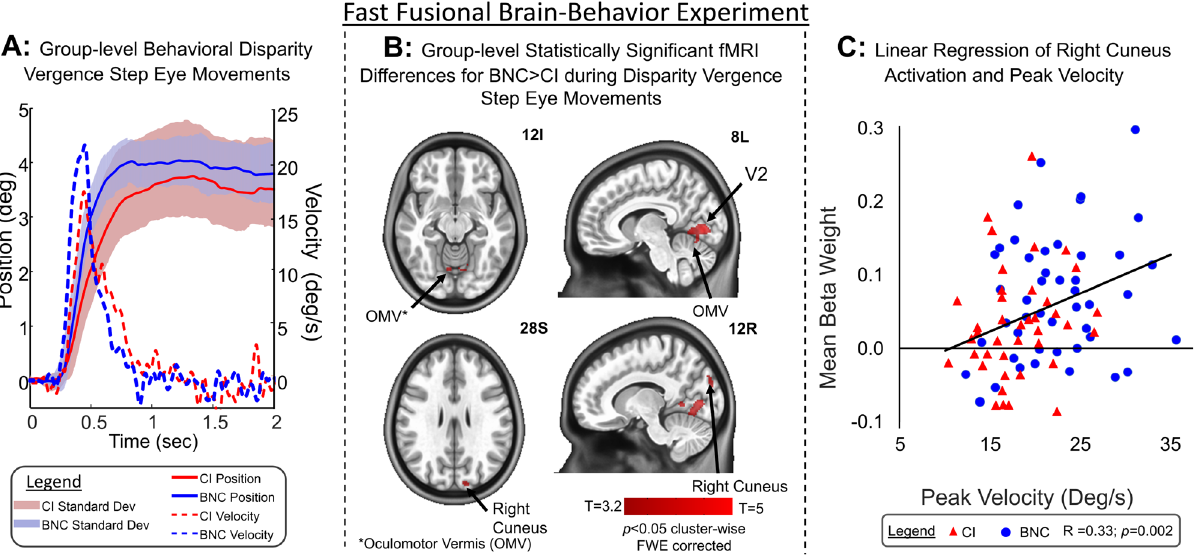
Figure 1. ( A ) Averaged vergence eye movement position (°) as a function of time (s) from BNC (solid blue line) and CI (solid red line) participants with ± one standard deviation (BNC blue shaded and CI red shaded) with the averaged peak velocity (°/s) as a function of time (s) from BNC (dashed blue line) and CI (dashed red line) participants. ( B ) Two-sample unpaired t-test of functional activity differences between BNC and CI groups during the vergence jump step fast fusional experiment showing V2, OMV, and right cuneus are significantly different between groups. ( C ) Linear regression of mean beta weight from right cuneus ROI using a 5 mm radius sphere as a function of peak velocity for BNC (blue circle) and CI (red triangle) participants. Linear regression (solid black line) analysis shows Pearson’s correlation coefficient of r = 0.33, p = 0.002 between right cuneus functional activity and vergence peak